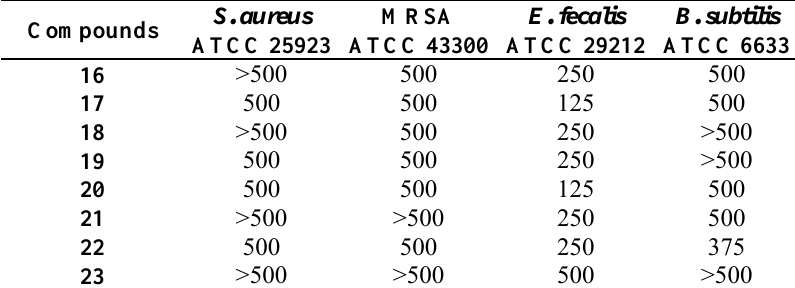
Table1. MIC ( μ g/mL) values for BZS compounds 16 - 23